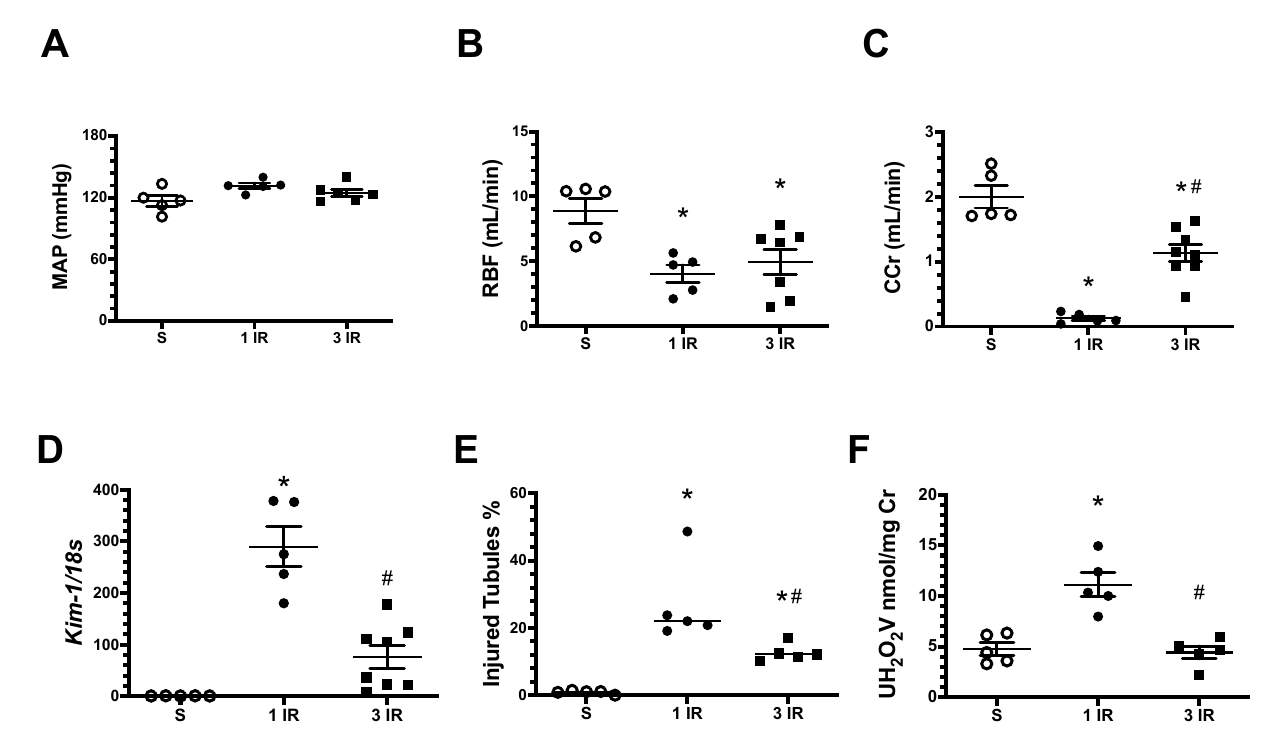
Figure 4. Repeated episodes of IR 45 min provoke renoprotection 24 h after the last episode. Animals with one or three episodes of IR were studied 24 h after the last episode. ( A ) Mean arterial pressure (MAP), ( B ) renal blood flow (RBF), ( C ) clearance of creatinine (Ccr), ( D ) Kim-1 mRNA levels, ( E ) per- centage of injured tubules, and ( F ) urinary H 2 O 2 excretion. The sham group is represented in white circles, the 1IR group in black circles, and the 3IR group in black squares. * p < 0.05 vs. S; # p < 0.05 vs. the 1IR